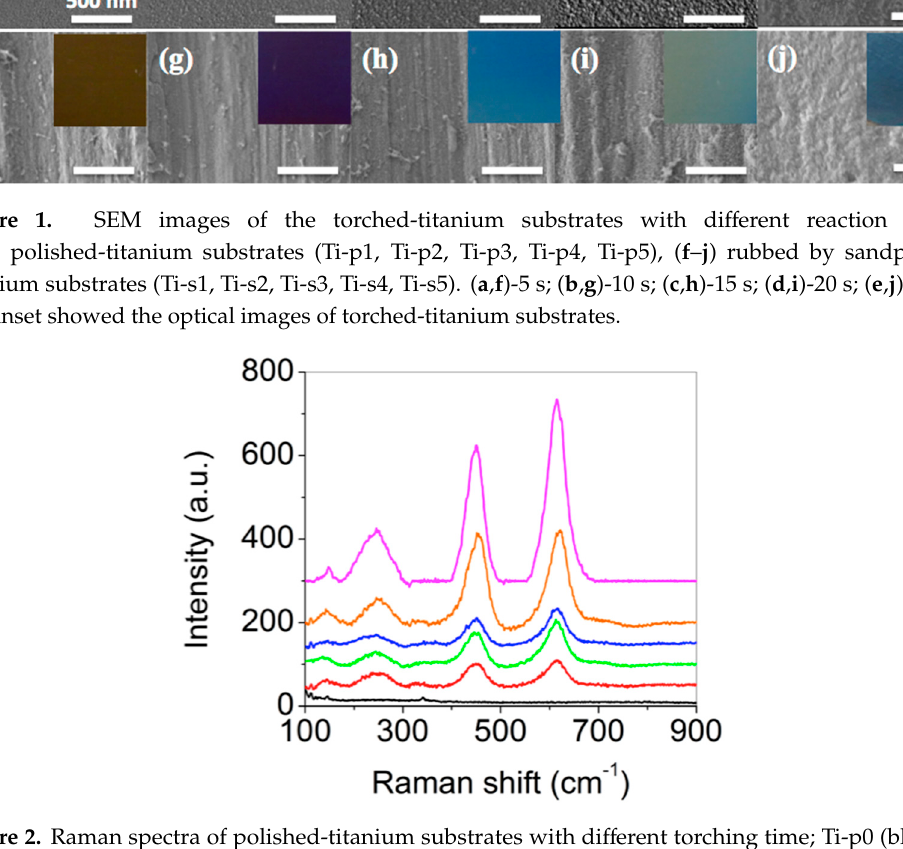
Figure 2. Raman spectra of polished-titanium substrates with different torching time; Ti-p0 (black), Ti-p1 (red), Ti-p2 (green), Ti-p3 (blue), Ti-p4 (orange), and Ti-p5 (magenta). The intensity of Ti-p5 was divided by 5.